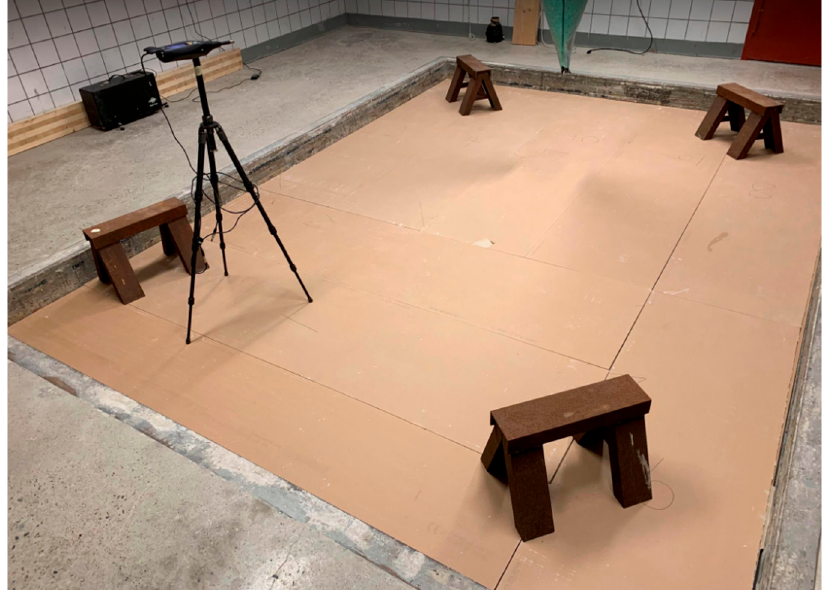
Figure A3. Photo of the laboratory measurement setup, with a sample area of 12.3 m 2 . Floor gypsum boards are used as the top layer in this case, as well as four metal components for some additional weight to approximate furniture mass at the corners.